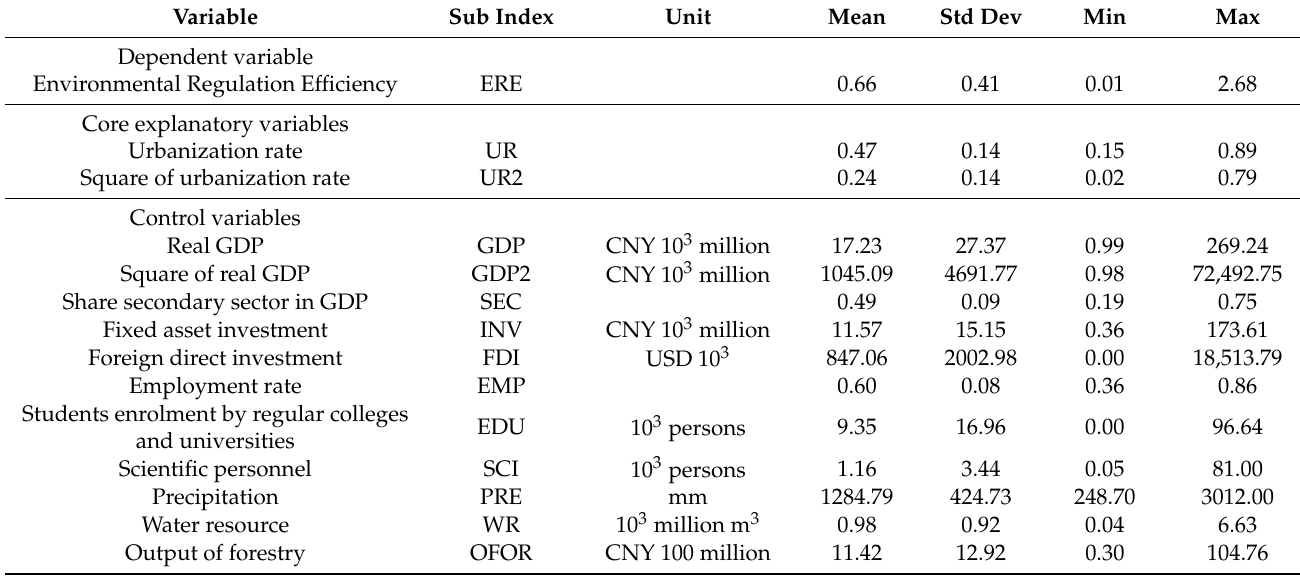
Table 1. Descriptive statistics of each